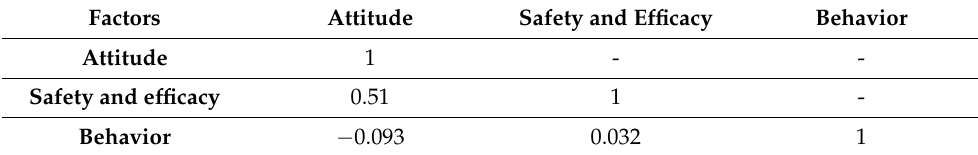
Table 5. Divergent validity of the Parental Attitudes About Childhood Vaccines (PACV) Tool.